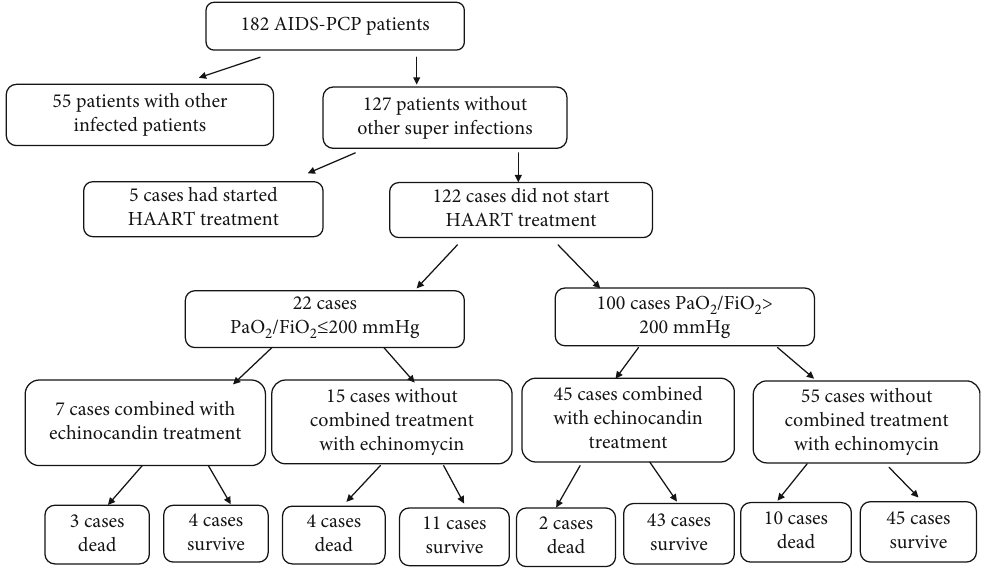
Figure 1: Flow chart indicating the process underlying patient selection and group classi fi cation. Table 1: Clinical and demographic characteristics of AIDS-PCP patients investigated in this study, China, 2013-2018. Demographic data